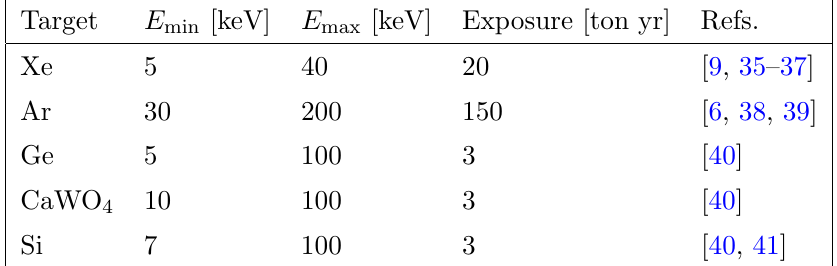
Table 1 . Mock experiments considered. In all cases, we assume a nominal e(cid:14)ciency of 70%, which should be considered as the product of the signal detection e(cid:14)ciency and the duty cycle of the